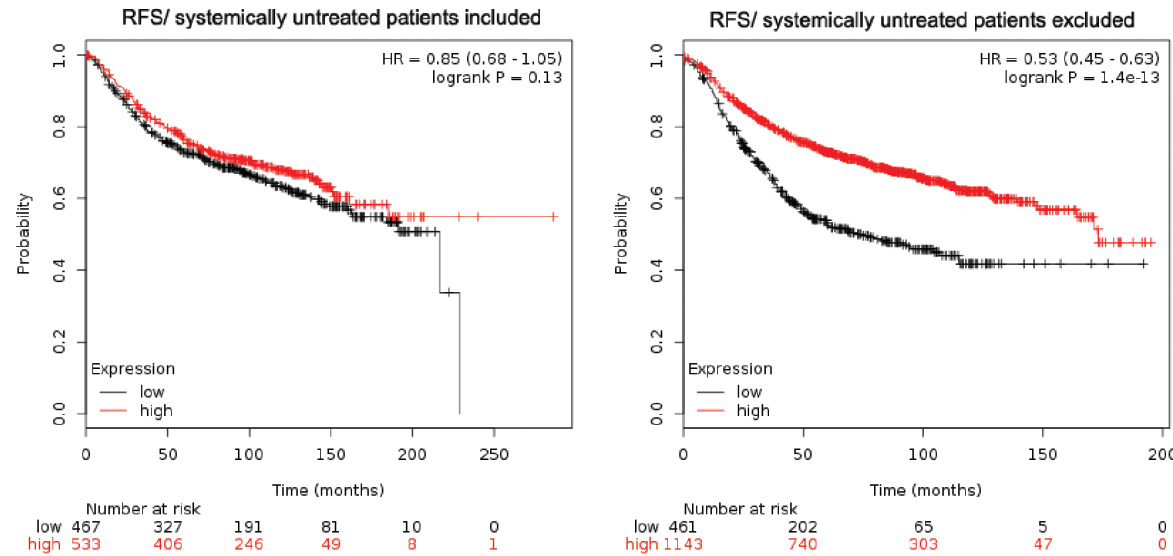
Figure 2. The confounding effect of systemic therapy on the prognostic value of EphB2 in breast cancer. Kaplan–Meier curves were generated using relapse-free survival (RFS) from the survival data of www.kmplot.com, depending on inclusion or not of systemically treated patients. For each analysis, survival of two groups of patients, with low versus high EphB2 mRNA expression levels, was compared, and both hazard ratios (HR) with 95% confidence intervals and log-rank P values were calculated.